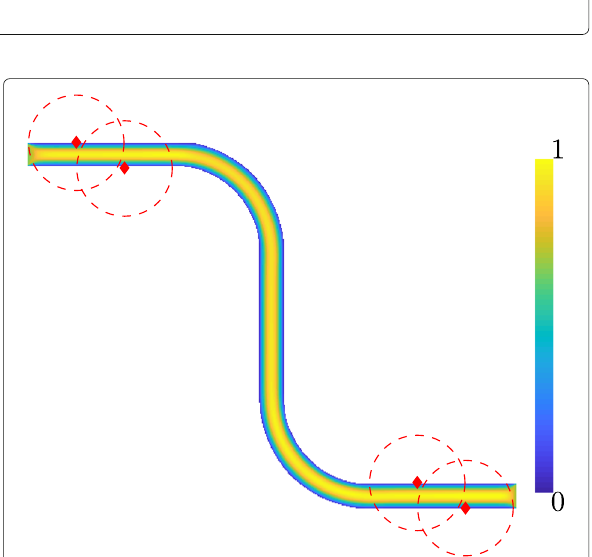
Fig. 3 Simulation environment used in this work. A color scale ranging from blue to yellow is used to show the normalized velocity. Additionally, the locations of the four beacons and their communication range are indicated as red diamonds and dashed circles,